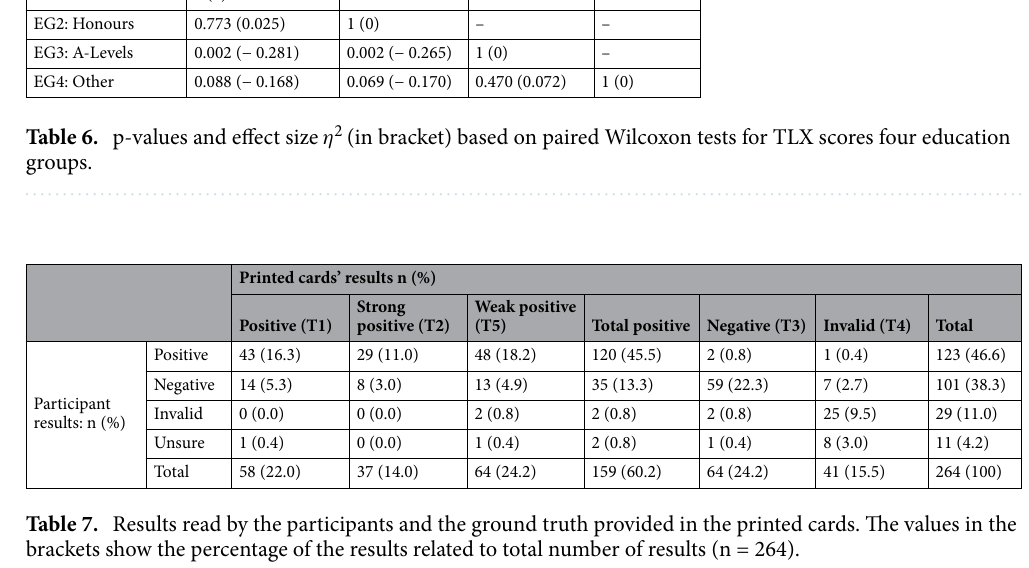
Table 7. Results read by the participants and the ground truth provided in the printed cards. The values in the brackets show the percentage of the results related to total number of results (n = 264).